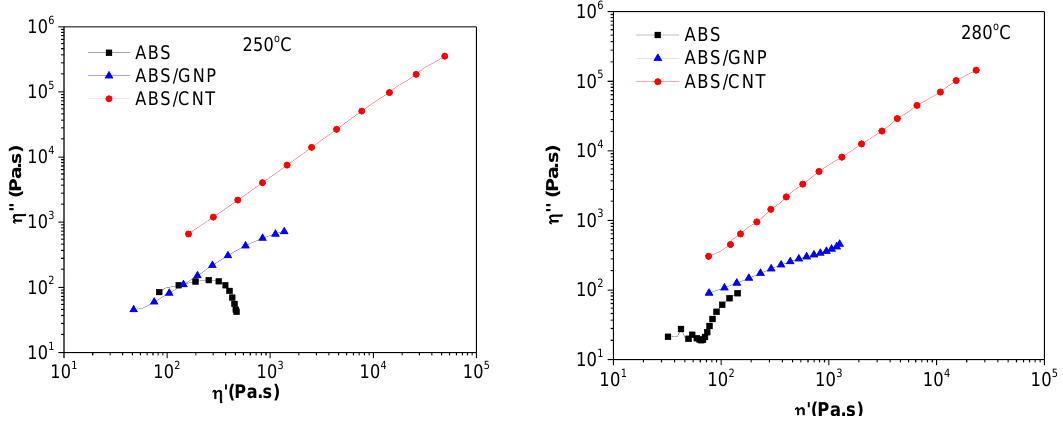
Figure 6. Cole-Cole plots of imaginary viscosity ( η ”) versus real viscosity ( η ’) of ABS, ABS/GNP and ABS/CNT nanocomposites at 250 and 280 °C.